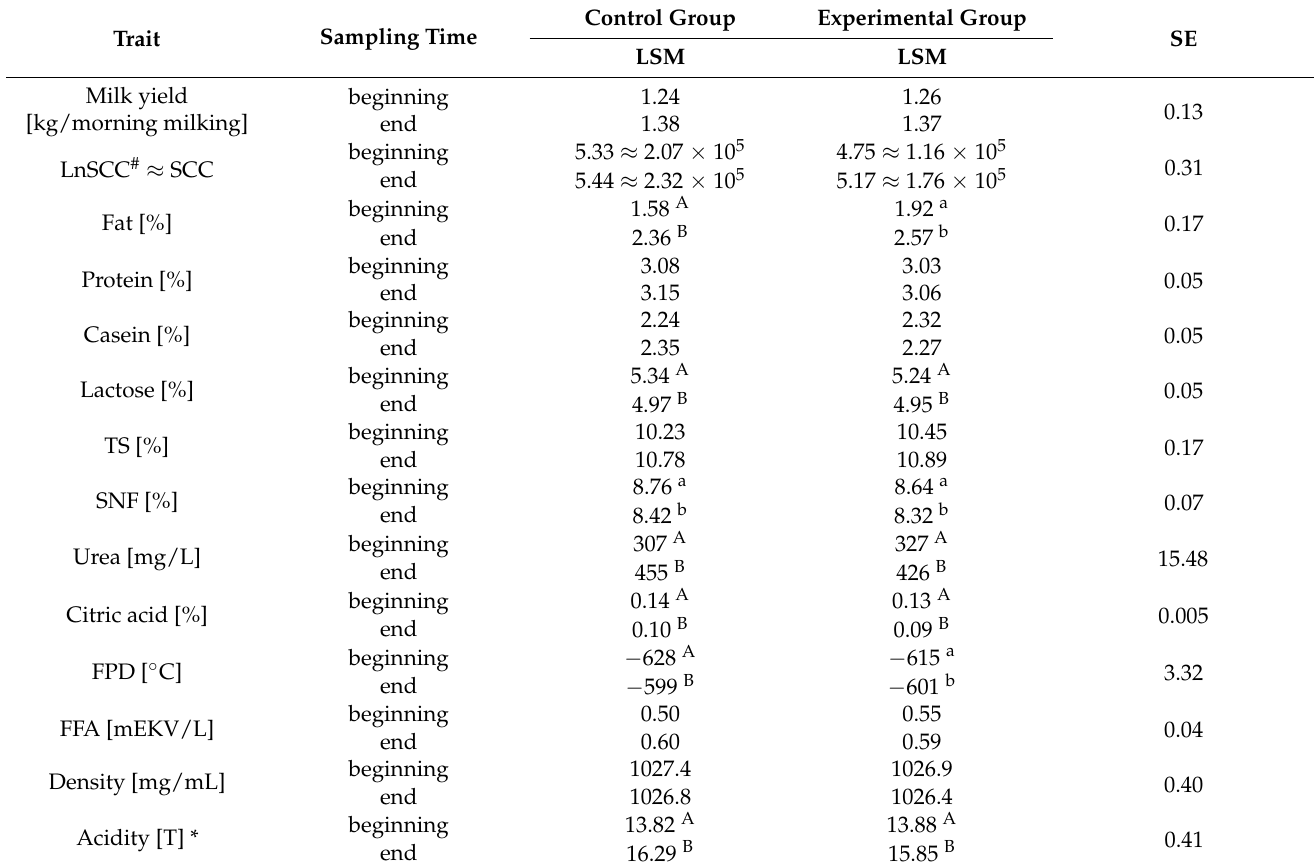
Table 3. The yield and composition of milk from morning milking in Herd II at the beginning and end of the